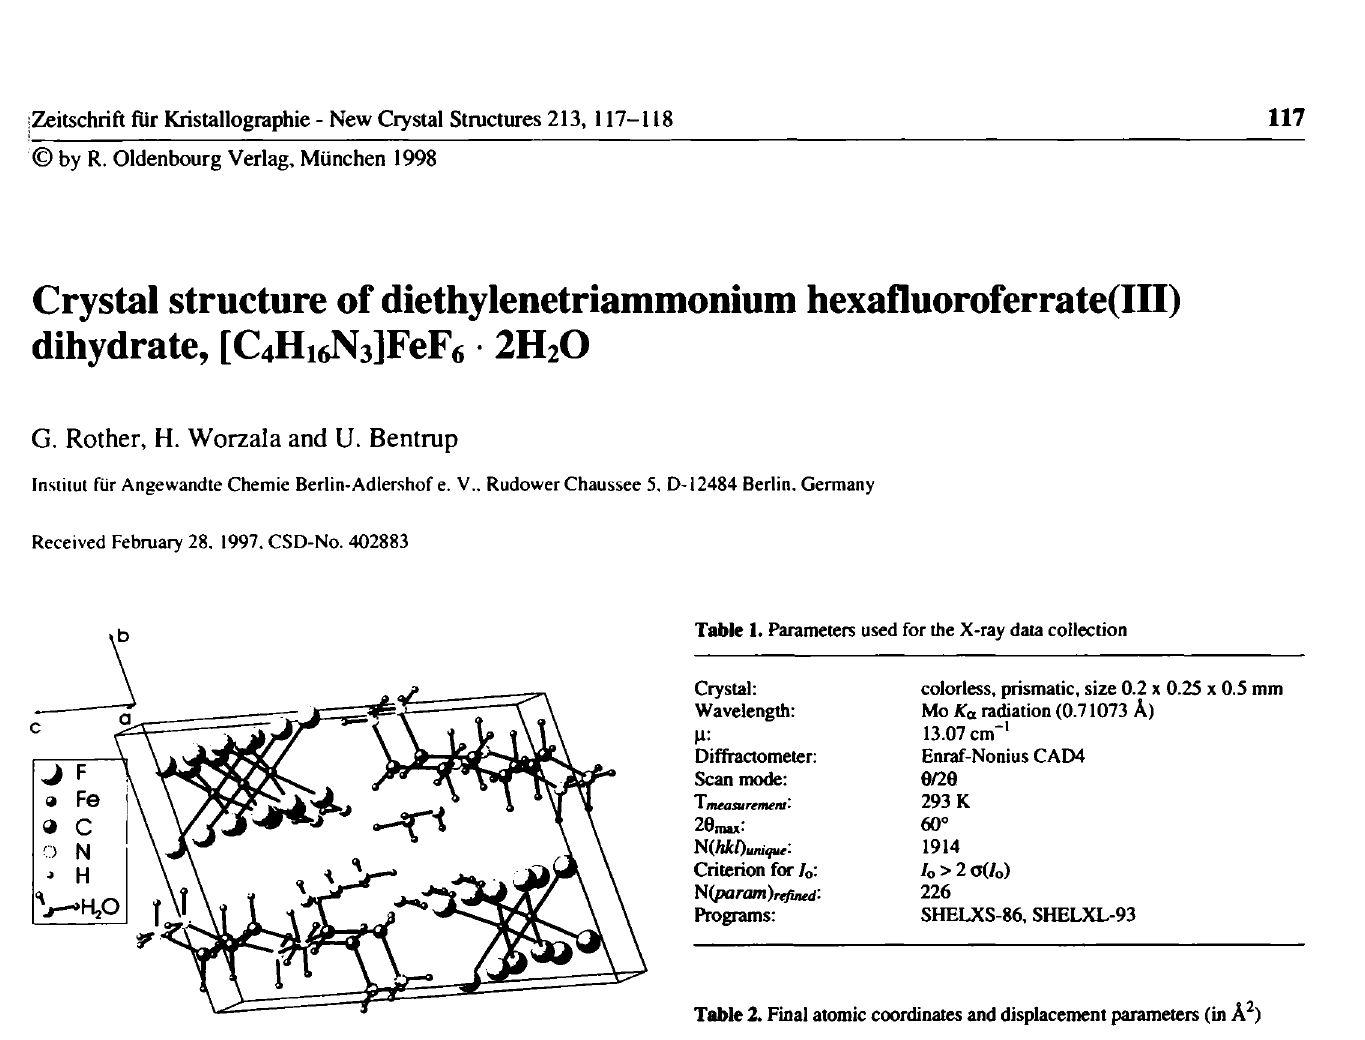
Table 2. Final atomic coordinates and displacement parameters (in A^)